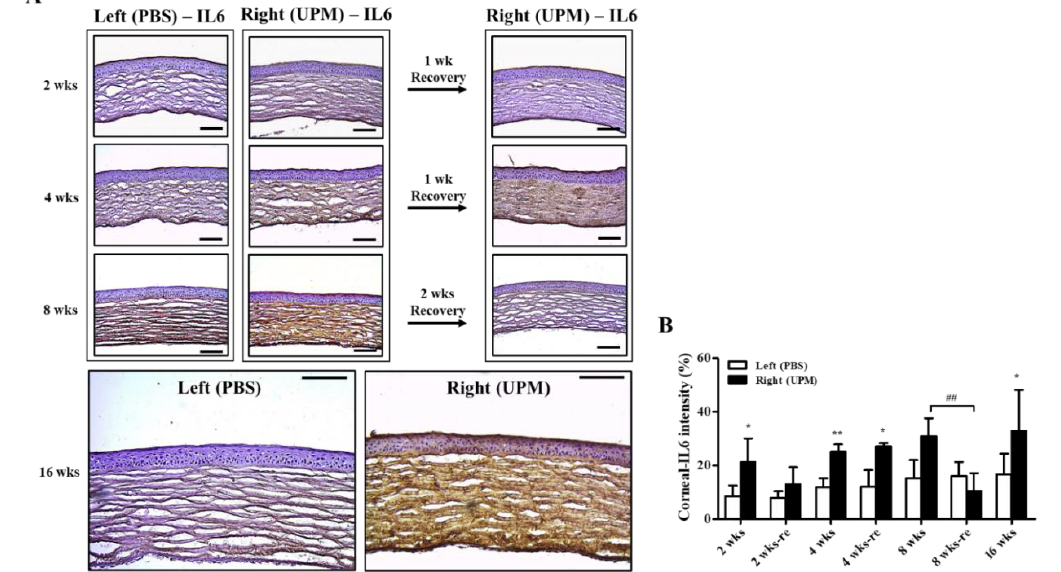
Figure 6. Effect of UPM on corneal IL-6 expression according to exposure period. ( A ) Images of immunohistochemical staining for IL-6 in corneas acquired at 200 × magnification from all experimental periods are shown. The scale bars indicate 100 µ m. ( B ) The relative intensities of IL-6 in the cornea are expressed as a graph. Data are expressed as the mean ± SD. * p < 0.05, ** p < 0.01 vs. left eye at the same time point. ## p < 0.01 between 8 weeks (8 wks) and two weeks of rest at 8 weeks (8 wks-re) of right eyes.